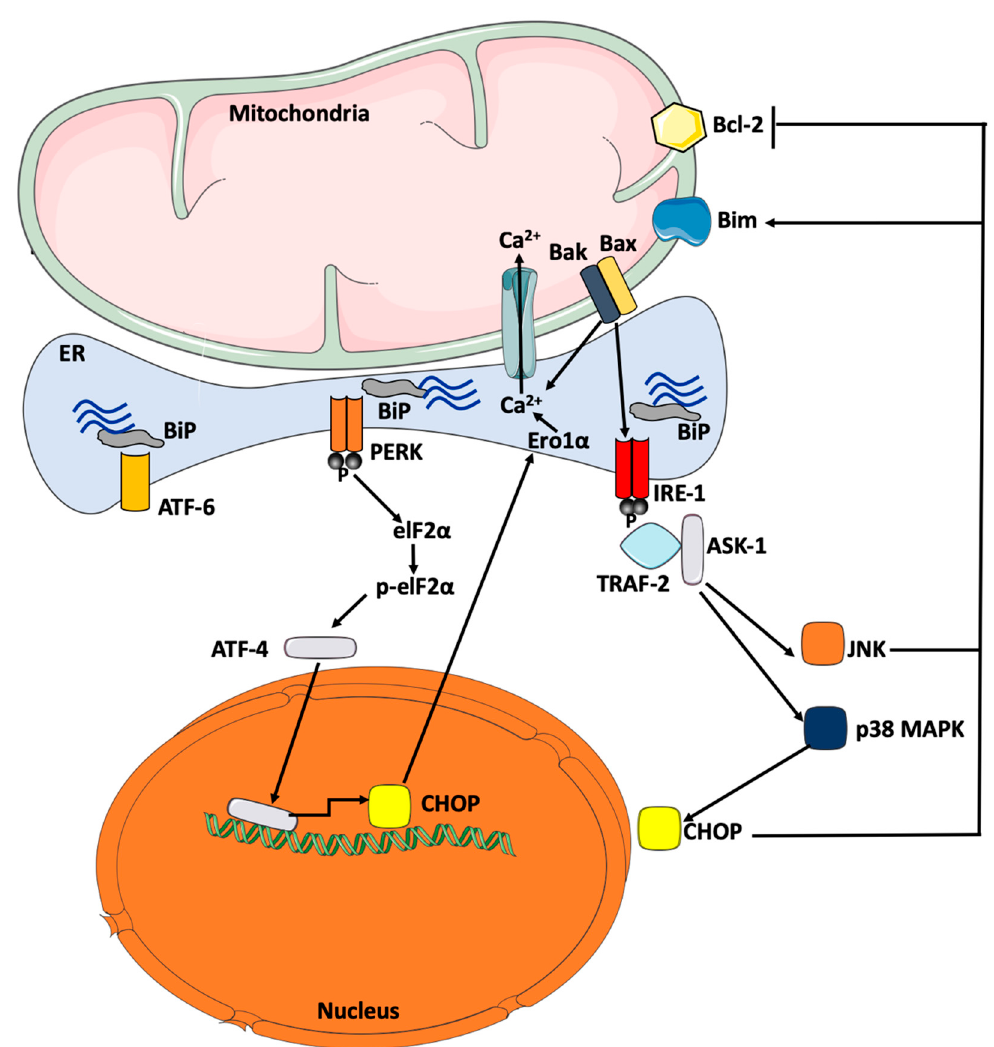
Figure 2. ER stress-induced apoptotic signaling pathways. Tumor necrosis factor- α receptor associated factor (TRAF-2) and apoptosis signal-regulating kinase (ASK)-1 are recruited by IRE-1 α triggering the activation of JNK and p38 mitogen-activated protein kinase (MAPK). Activated JNK transfers to the mitochondrial membrane where it concomitantly activates Bim and inhibits Bcl-2. Active p38 MAPK will phosphorylate and, hence, activate CHOP, which in turn, stimulates the transcription of genes involved in apoptosis, such as ER oxidoreductase (ERO)-1 α . Bax and Bak also interact and, hence, activate IRE-1 α leading to depletion of Ca 2+ ER stores. Via its kinase activity, PERK phosphorylates the elongation factor, elF-2 α , and, hence, reduces general protein translation while allowing selective translation of specific genes ding JNK and NF- κ B, which may activate pro-inflammatory and apoptotic signals, such as CHOP.